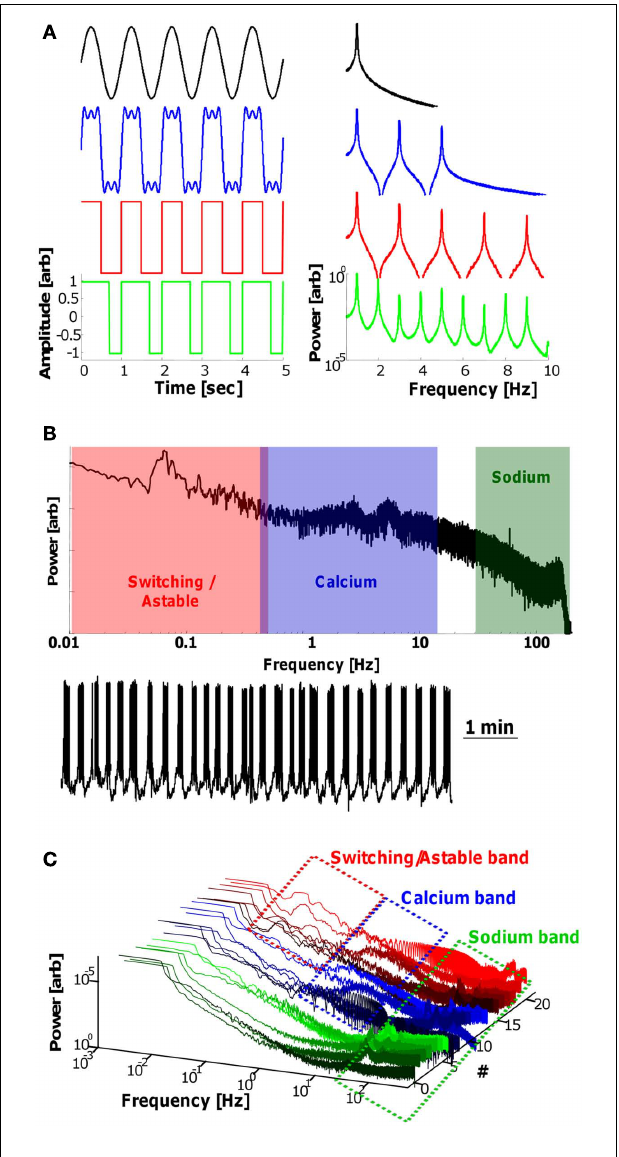
FIGURE 1 | Fourier transforms and Purkinje firing output. (A) Time-domain (left) and frequency domain (right, logarithmic y -axis) descriptions of mathematical signals. From top: (black) a single 1Hz sine; (blue) combination of sin( t ), sin(3 t ), and sin(5 t ), approximating a 1Hz square-wave; (red) a perfect square-wave can be described as a series of odd integer harmonics of sine waves; (green) a 70% duty-cycle, 1Hz square-wave has integer harmonics with different frequency coefficient heights. (B) FT of a 9min patch-clamp recording from a Purkinje neuron in vitro (below) consisting of three-frequency range windows: Switching/Astable ( < 1Hz, red); Calcium (0.7–15Hz, blue); Sodium ( > 30Hz, green). (C) Twenty-one FTs of 7min recordings of spontaneously firing Purkinjes in vitro arranged showing all the cells displaying Sodium frequencies, 2/3 with Calcium frequencies, and 1/3 with Switching/Astable frequencies. (see Abrams et al., 2010, for experimental